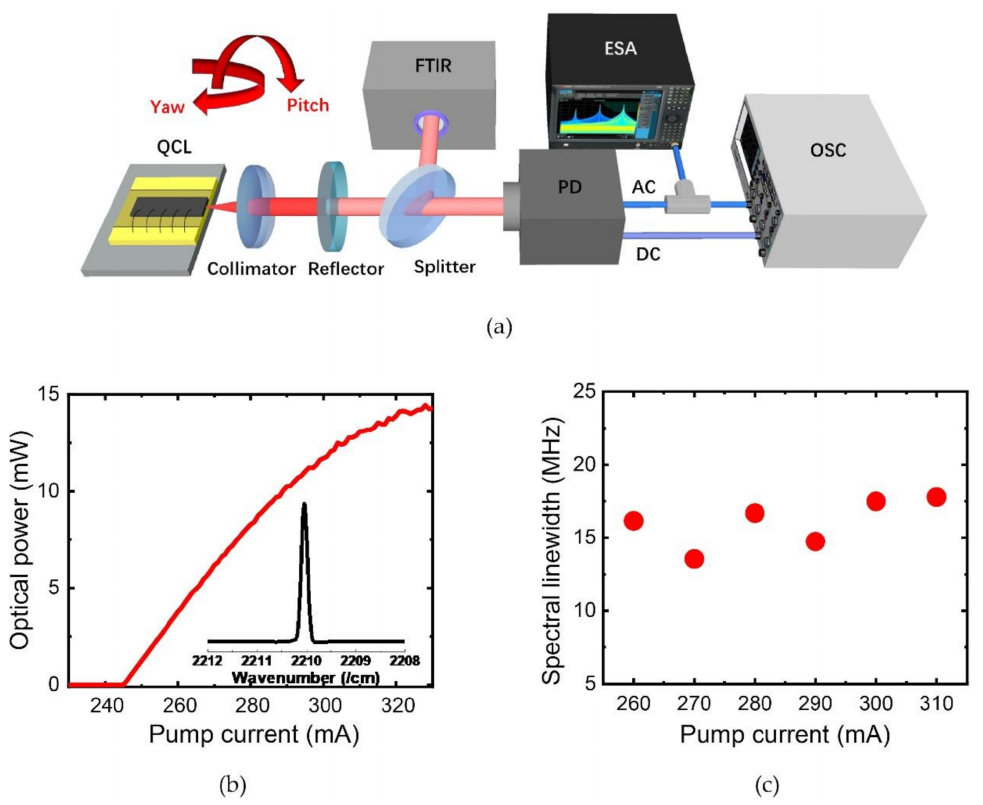
Figure 1. ( a ) Experimental setup for the modulation using P1 dynamics. FTIR, Fourier transform infrared spectrometer; PD, photodetector; ESA, electrical spectrum analyzer; OSC, oscilloscope. ( b ) L-I curve. Inset is the optical spectrum at 280 mA. ( c ) Optical linewidth versus the pump current. The reflector in ( a ) is tilted in the yaw direction. The tilt angle is zero when the reflector is well aligned with the optical path and is positive when the reflector is tilted in the arrow direction.